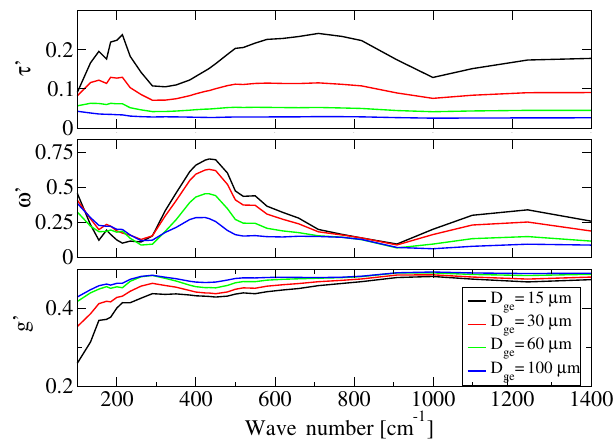
Figure 2. Radiance sensitivity to parameter variation for a sum- mer atmospheric state and a cirrus cloud of 1km with the bottom at 1800m above ground, τ = 1 and D e =